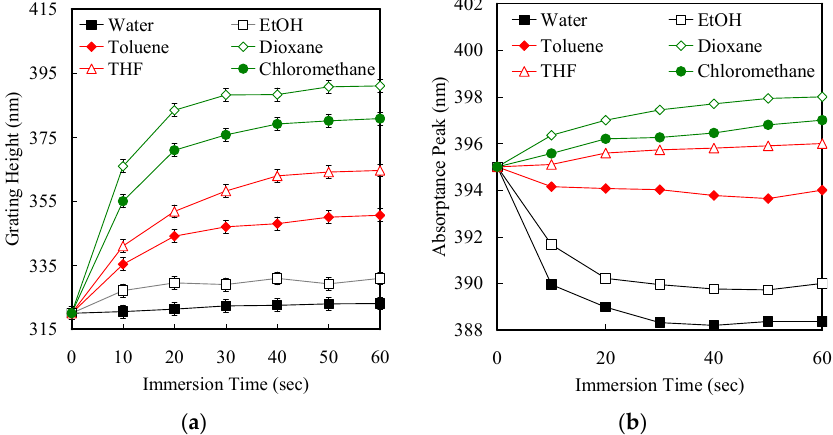
Figure 7. ( a ) Grating height and ( b ) absorptance peak of PQ1.5 plotted with respect to immersion times in various solvents.